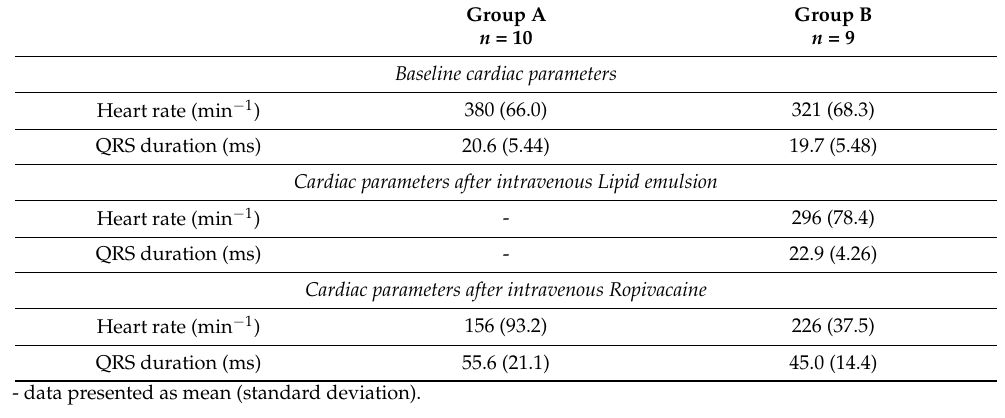
Table 1. Cardiac response to intravenous ropivacaine preceded or not by administration of lipid emulsion.